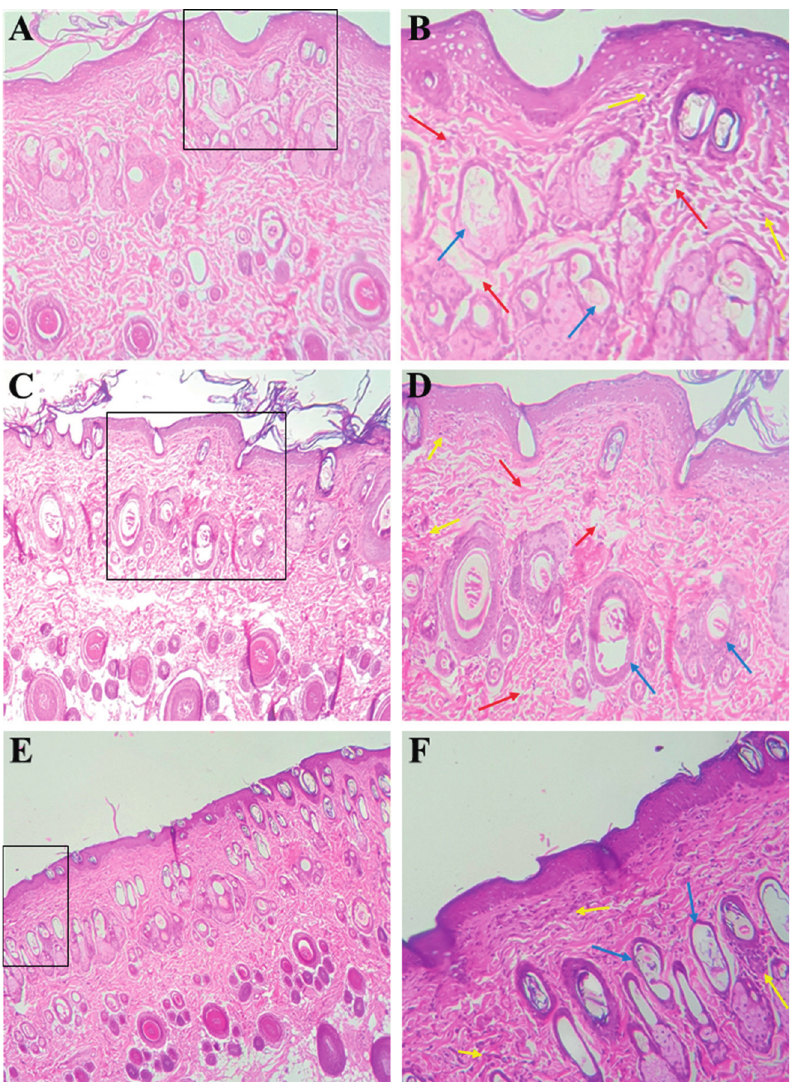
Figure 6: Histological analysis (thickness, inflammatory cells infiltration, collagen fiber regulation conditions) on day 7. Control (A; × 40, B; × 100), betamethasone (C; × 40, D; × 100), ASC groups (E; × 40, F; × 100) (red arrows: collagen necrosis; blue arrows: collagen bundles; yellow arrows: inflammatory cells